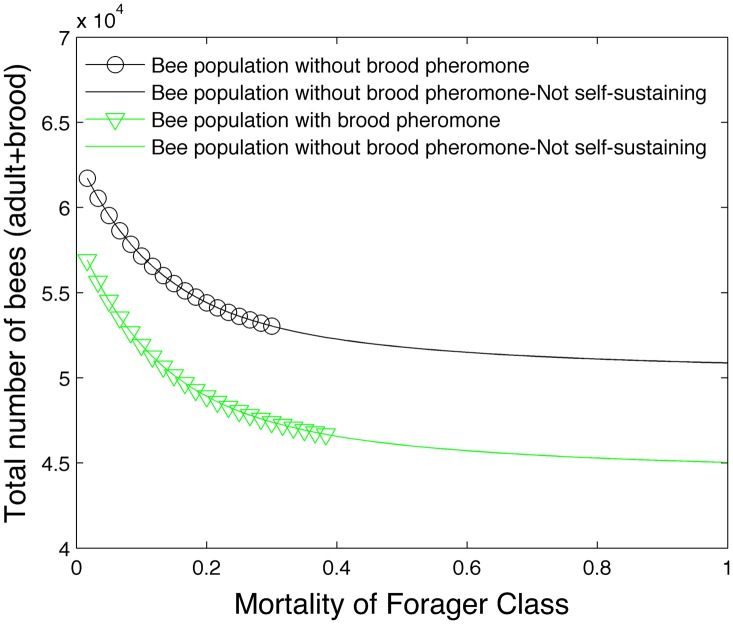
Effect of brood pheromone on bee population.